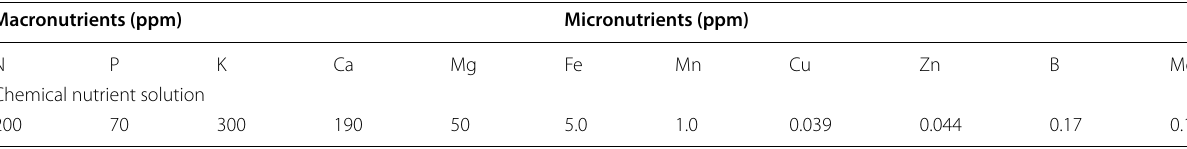
Table 2 The chemical composition of the nutrient solution Macronutrients (ppm) Micronutrients (ppm) Chemical nutrient